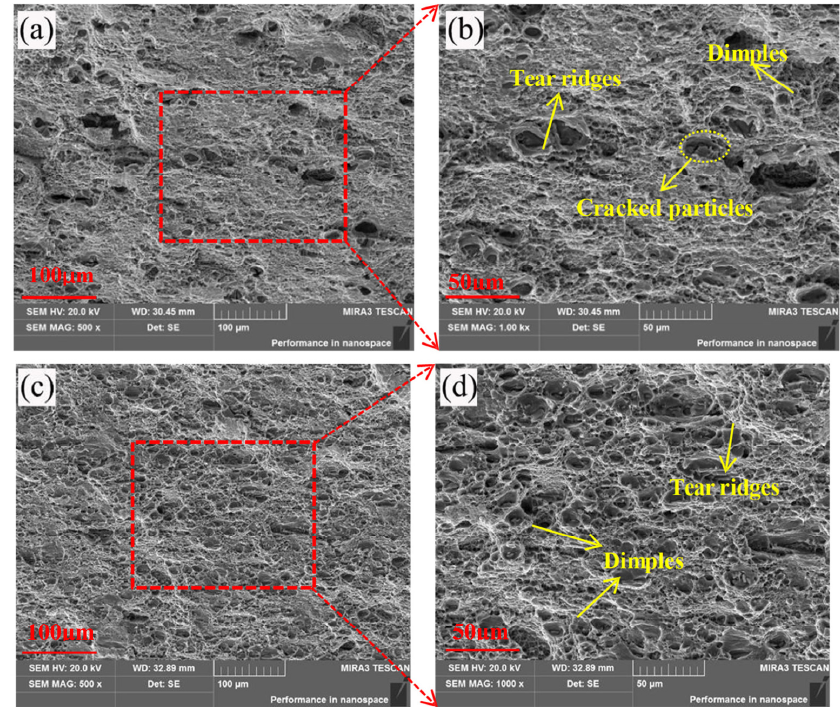
Figure 9. Fracture surface micrographs of the welding joint: ( a , b ) 2A5R, ( c , d )